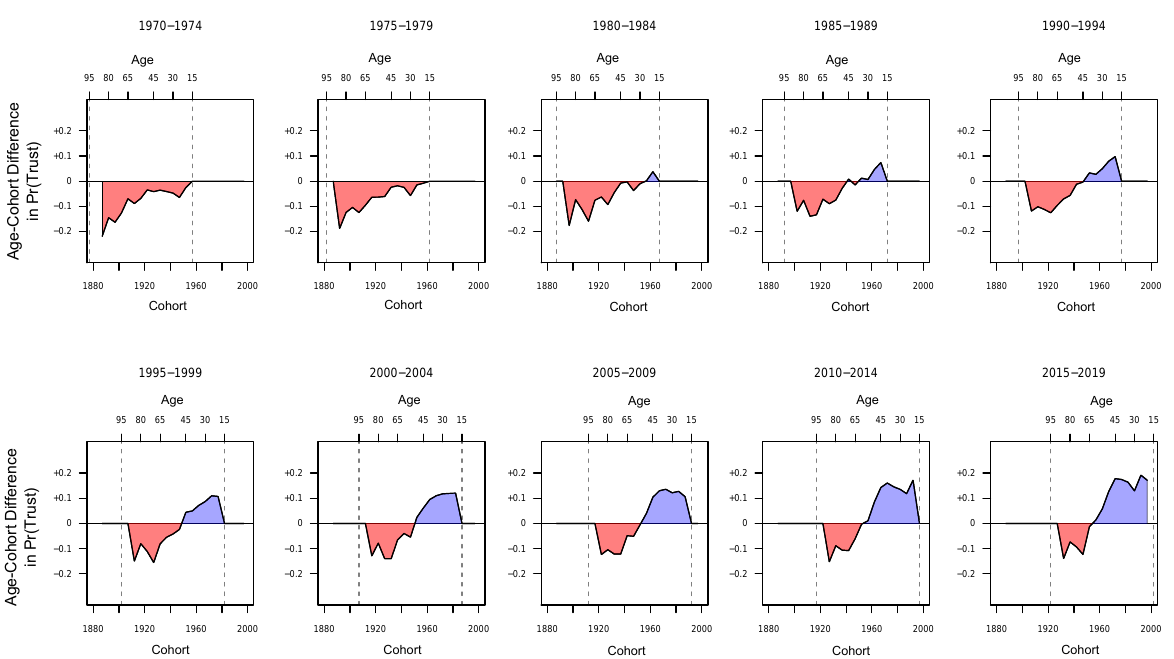
Figure 15: Trellis plot of local synchronic age differences. Notes: Each panel displays the difference in predicted probability of social trust for designated pairs of age and cohort levels. Calculations are based α i − γ j − i + I ) for i = 1, . . . , I in each period j . Top horizontal axes are age in years, on ( θ 1 − θ 2 )( i − i ∗ ) + ( bottom horizontal axes are cohort in years, and vertical axes are the difference in the predicted probability of social trust. The pairs of age and cohort levels that are compared vary based on age, which is a sliding (cid:101) (cid:101) window across periods. Vertical dotted lines denote the beginning and end points of the age window in each period. Positive (or negative) values indicate that, for particular age–cohort comparisons in a given period, parameters representing life-cycle change are greater (or less) than those for social change. All estimates are based on the age synchronic L-APC logistic regression model. Outcome is social trust, coded so that 1 = “can trust” while 0 = “can’t be too careful” or “depends.” Results adjusted using sampling